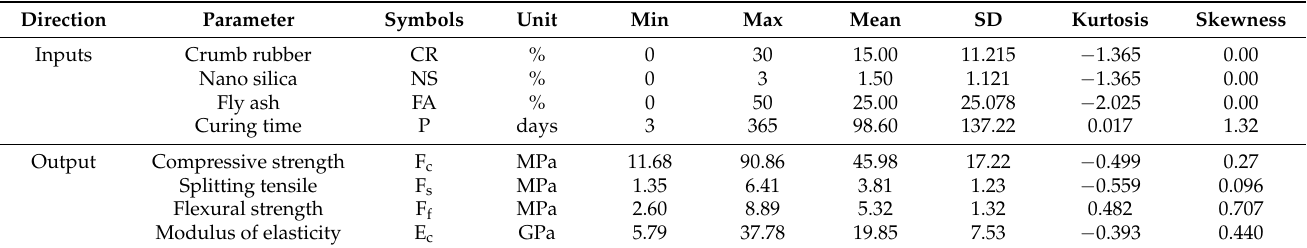
Figure 6. Correlation matrix using person correlation matrix. Table 5. Descriptive statistic of the experimental